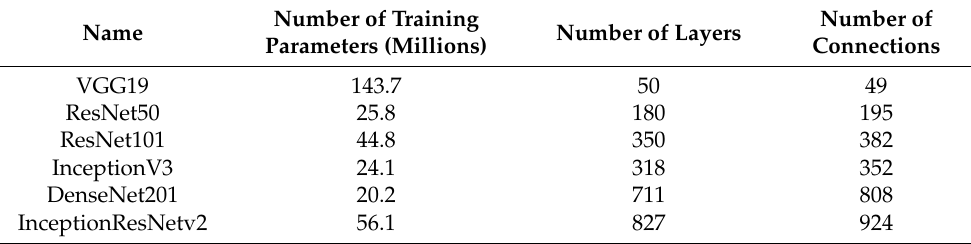
Table 2. Details of deep models.